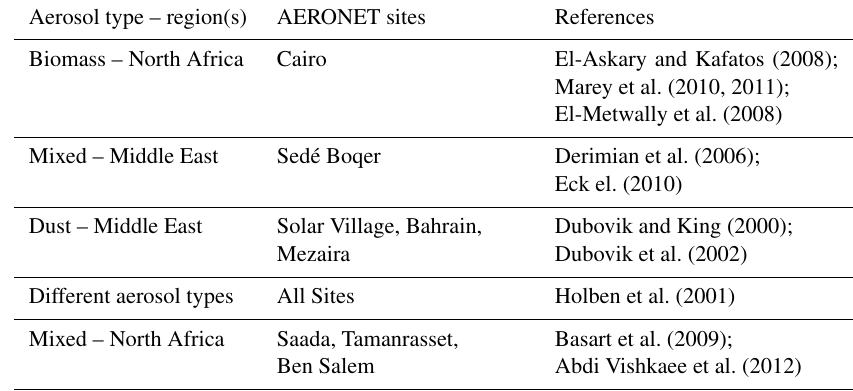
Table 1. Previous studies categorizing aerosol types over some of the AERONET sites presented in this work. Aerosol type –